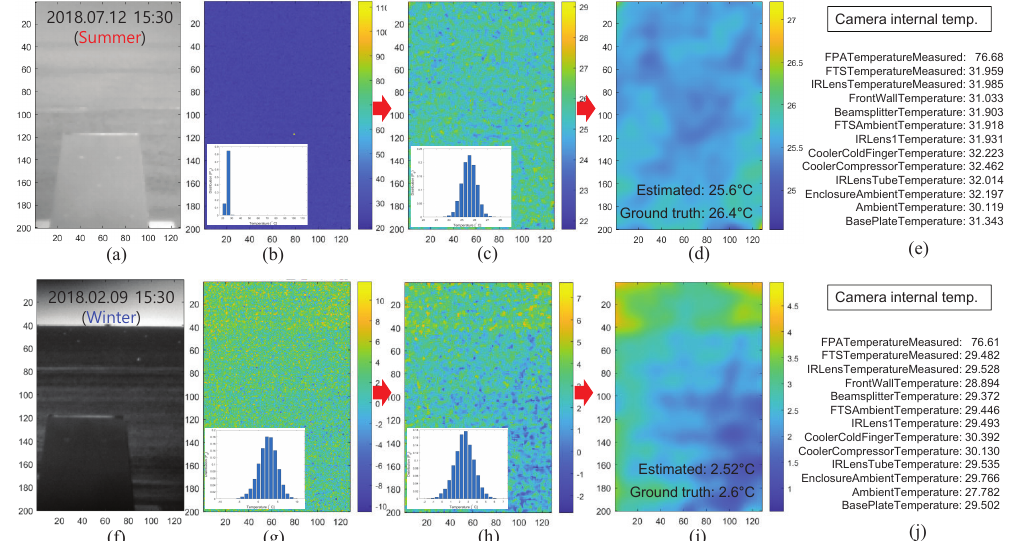
Figure 11. Indirect proof of air temperature measurement by extreme weather conditions: Hot summer-( a ) broad-band image, ( b ) CO 2 band image, ( c ) median filtered image, ( d ) Gaussian filtered image, ( e ) camera internal temperature information; Cold winder-( f ) broad-band image, ( g ) CO 2 band image, ( h ) median filtered image, ( i ) Gaussian filtered image, ( j ) camera internal temperature information.